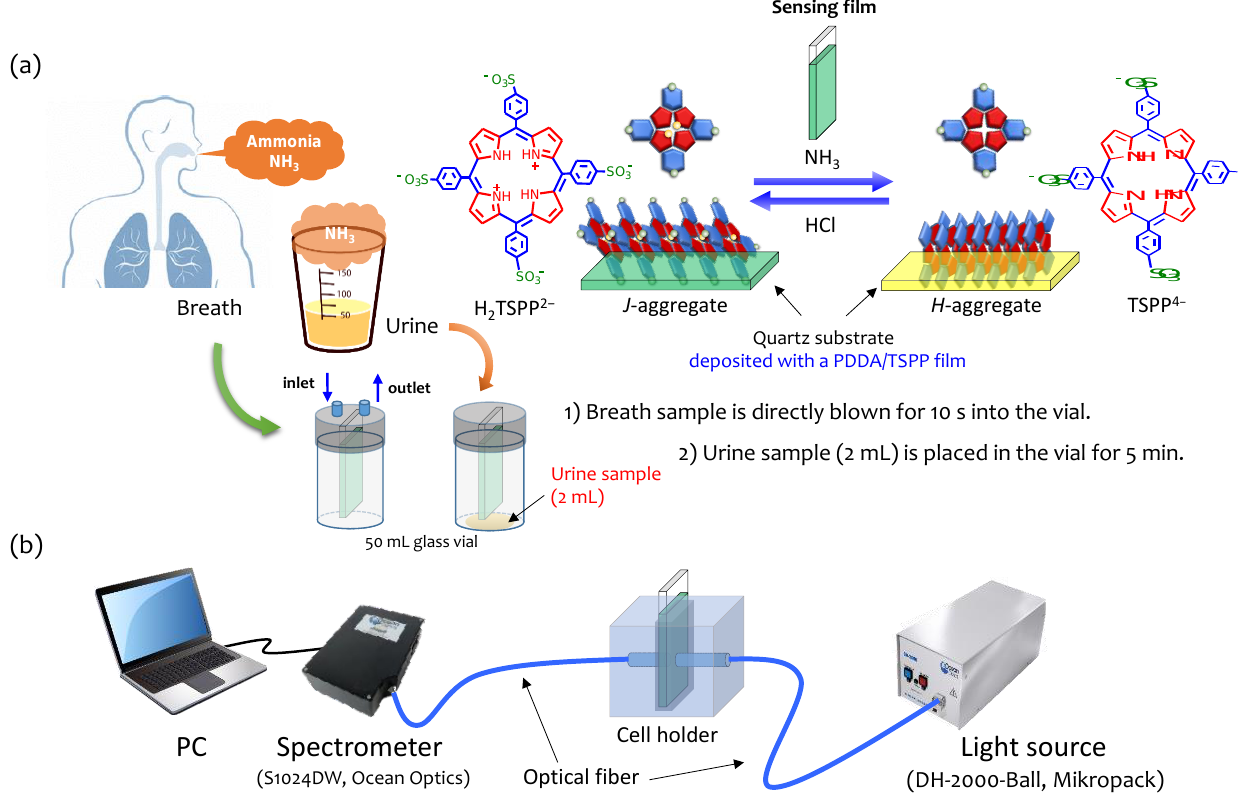
Figure 2. ( a ) Schematic of the sensing principle of ammonia included in breath and urine samples using a PDDA/TSPP LbL film deposited onto a quartz substrate via sensor recovery by HCl vapor treatment. ( b ) Measurement setup for UV–vis spectra acquisition of the sensor film after exposure to ammonia gas or HCl vapor.